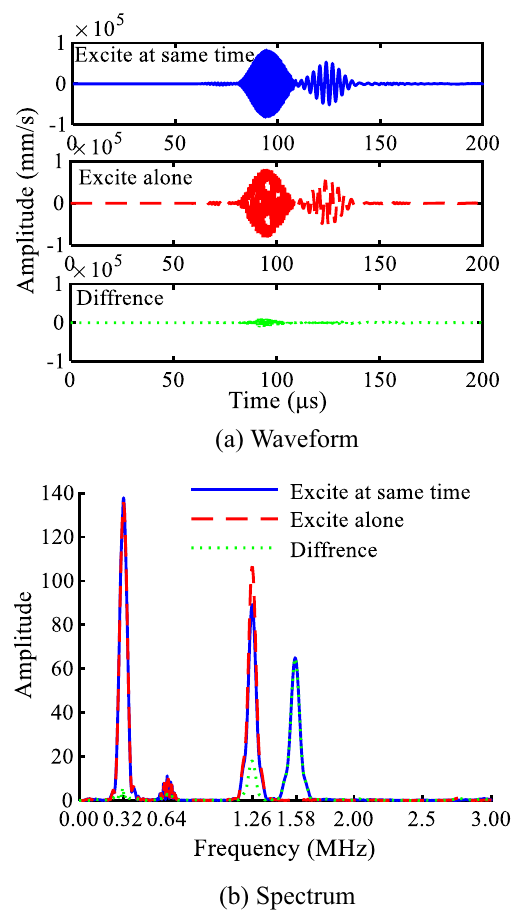
Figure 8 Results received at point 3 under different excitations